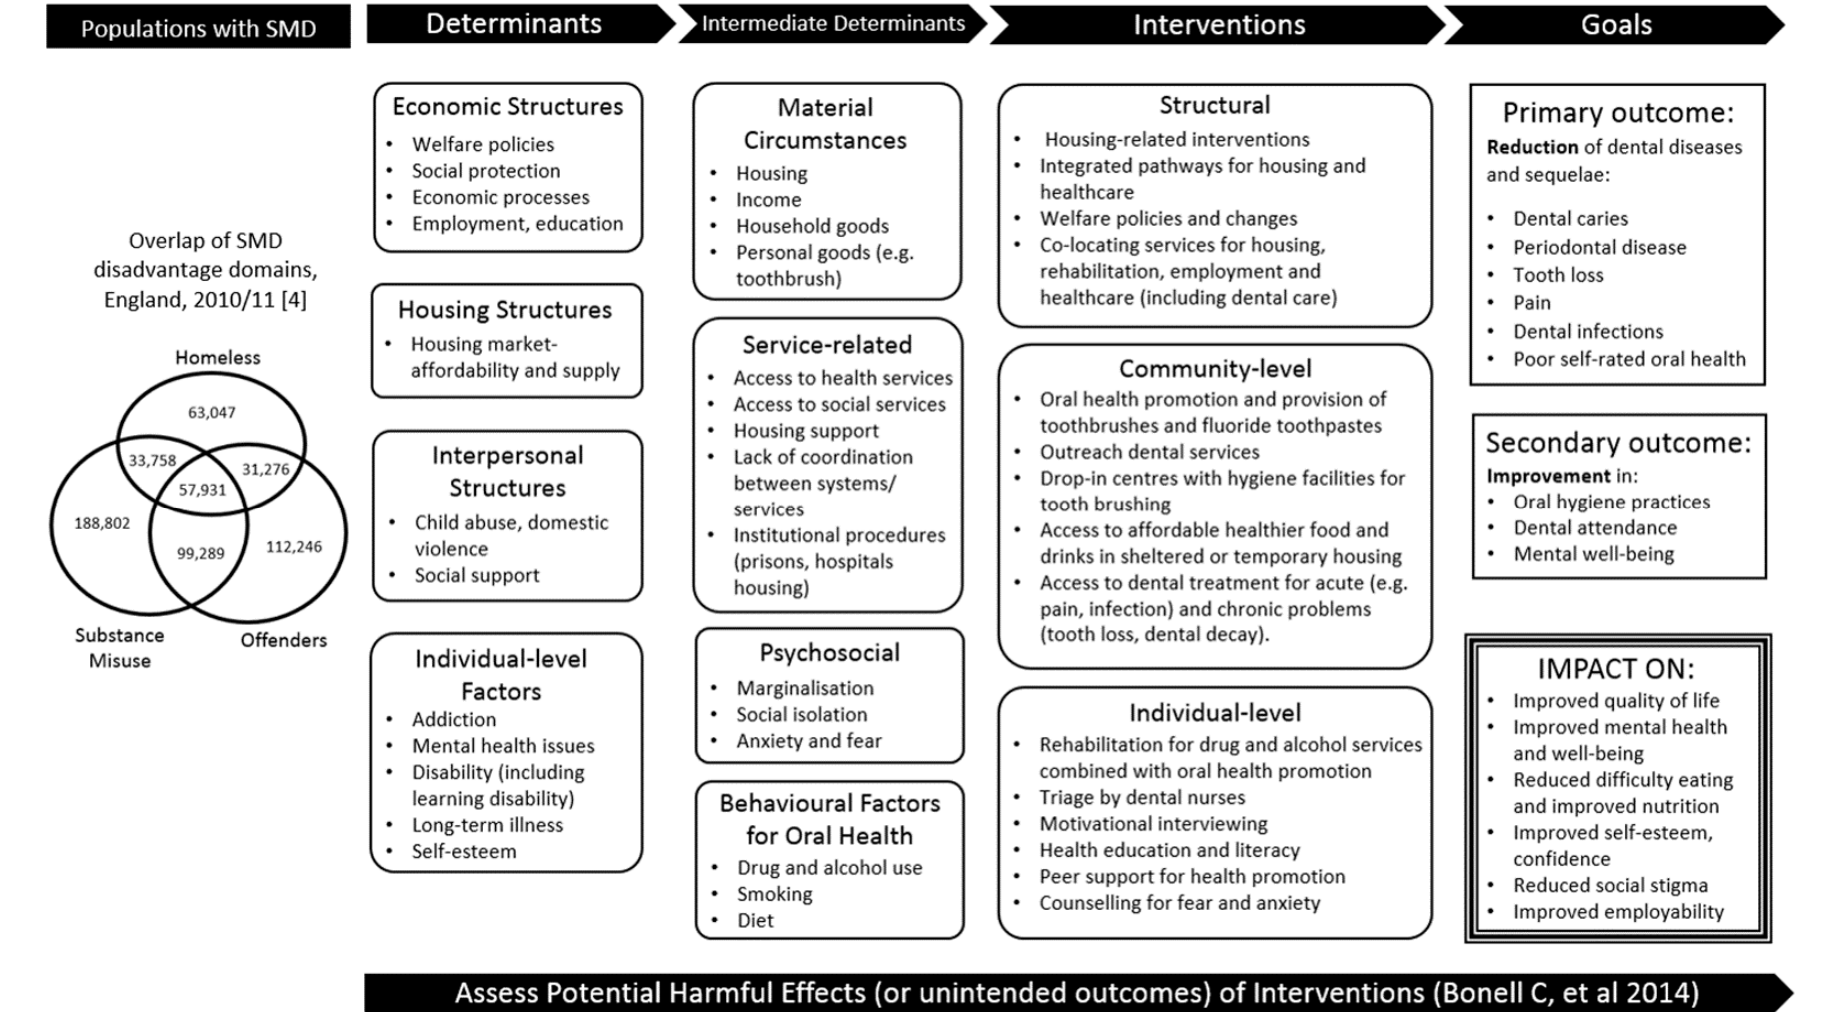
Figure 1. Initial logic model laying out the theoretical framework for identifying interventions to improve the oral health and related behaviours of adults with severe and multiple disadvantage (SMD).